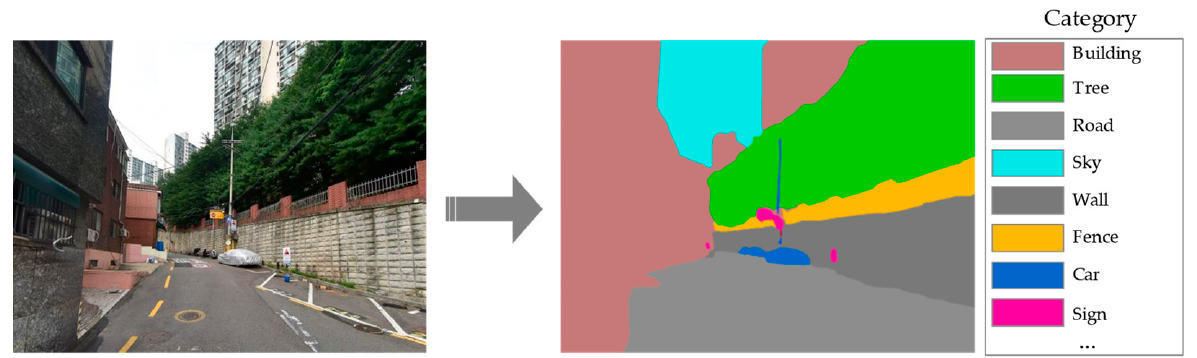
Figure 3. Example of a semantic segmentation result.